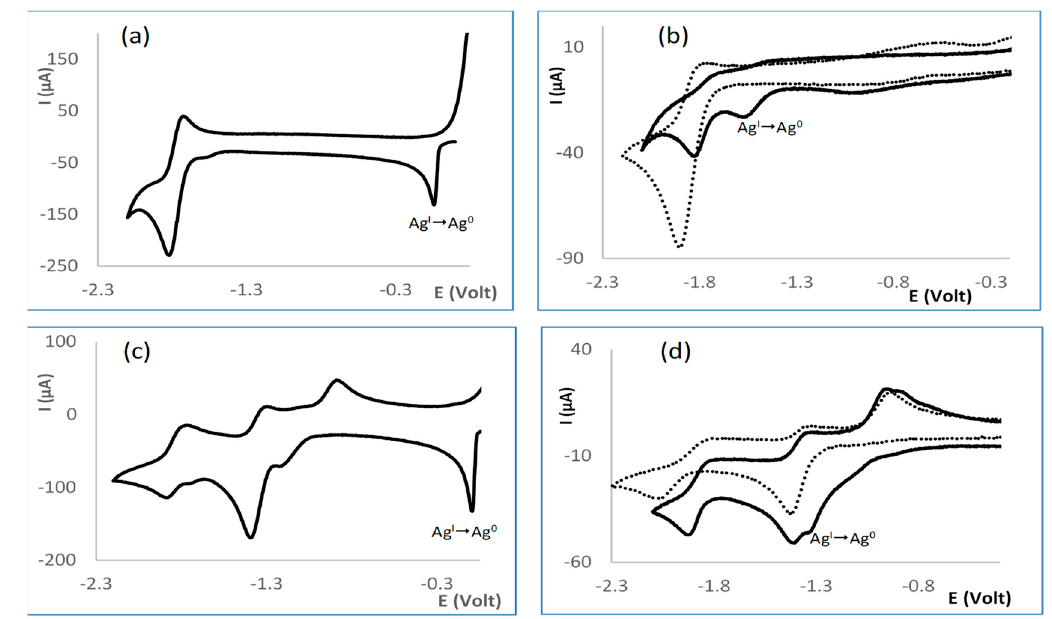
Figure 5. Partial cyclic voltammograms for ( a ) [Ag(NO 3 )(OC 10 H 14 NC 6 H 4 CH 3 ) 2 ] ( 5a ); ( b ) [Ag(OH)(OC 10 H 14 NC 6 H 4 NH 2 )] ( 7c ); ( c ) [Ag(NO 3 )(SO 2 NC 10 H 13 NC 6 H 5 ) 2 ] ( 9d ); ( d ) [Ag(OH)(SO 2 NC 10 H 13 NC 6 H 4 NH 2 ) 2 ] ( 10f ). Dashed lines at ( b , d ) refer to free ligands.